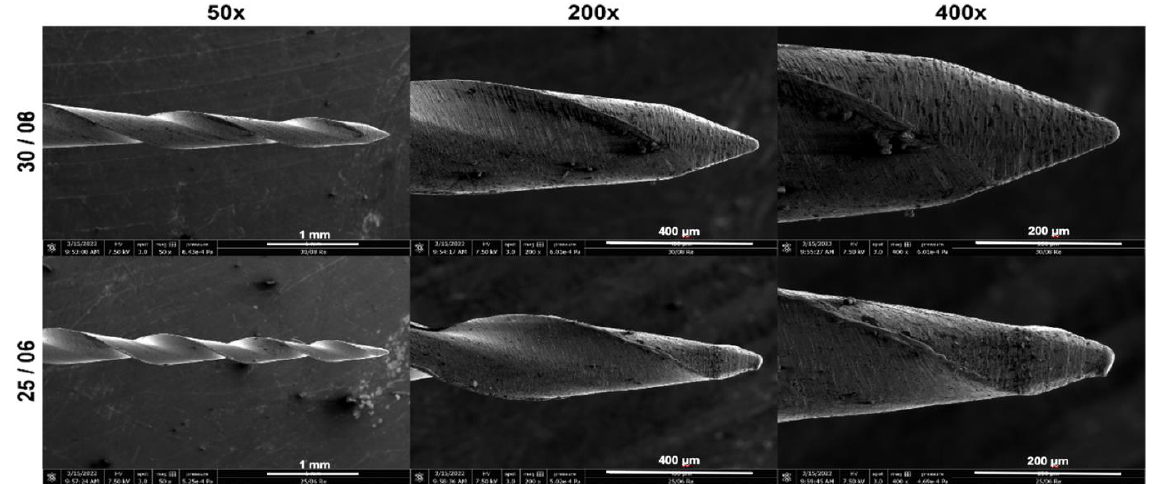
Figure 1. Scanning electron microscopy images demonstrating the Endostar REvision instrument (30/08 and 25/06).